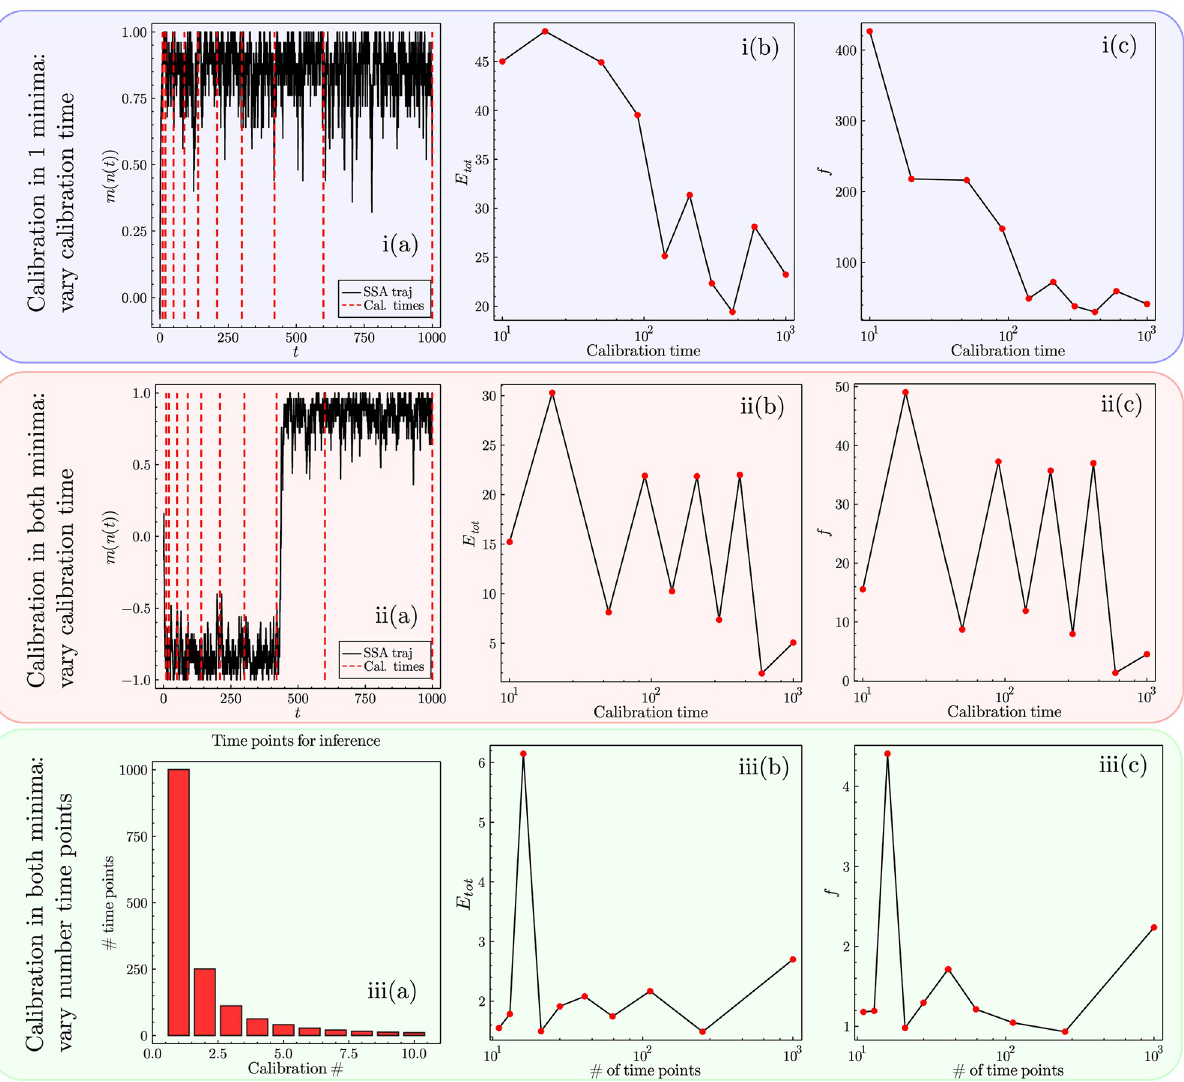
Fig 4. Figure showing the calibration procedure on a single trajectory/realisation of data produced by the SSA for the parameter set explored in Fig 3. (i) Exploring the calibration when only one equilibrium of the two is realised on the data trajectory. i(a) The data which we perform the calibration on, clearly showing that only the right-hand equilibrium is manifest. Red dashed lines show the various times used for calibration. In i(b) and i(c) we explore the various calibration times and plot the error on the calibrated parameters compared to the true values for E tot and f respectively defined in Eqs (41) and (42). Although larger calibration times result in better parameter inference there are still large errors � 1 even for large calibration times. (ii) Exploring the calibration procedure for a trajectory that realises both equilibria. ii(a) The trajectory that we use for calibration that explores both equilibria. ii(b) and ii(c) show that increasing the calibration time such that the exploration of both equilibria occurs results in much improved inference of the parameters where for calibration times � 10 3 the errors are of order O ð 1 Þ . (iii) Exploring the trajectory in ii(a) for a varied number of time/data points. iii(a) Bar chart showing the different number of time points explored in the calibration. iii(b) and iii(c) show that although having an increased number of time points benefits calibration, it does so with diminishing returns. Note throughout the figure that the optimiser used from BlackBoxOptim generally identifies good local minima of the likelihood function and not the global minimum due to the complexity of the likelihood function [62].